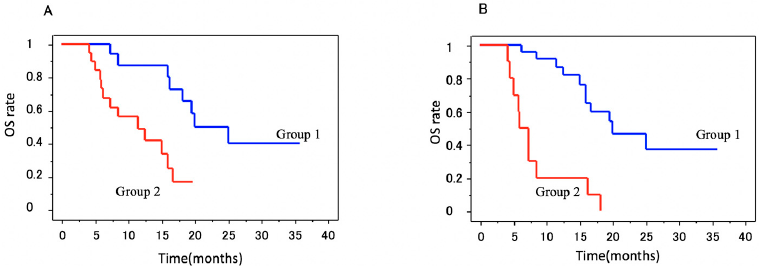
CTCs. There were 45 (75.0%) with EGFR-negative CTCs (group 1) that had a median overall survival time of 20.0 months compared with 5.5 months in 15 patients (25.0%) with EGFR-positive CTCs (group 2) ( p < 0.001, log-rank